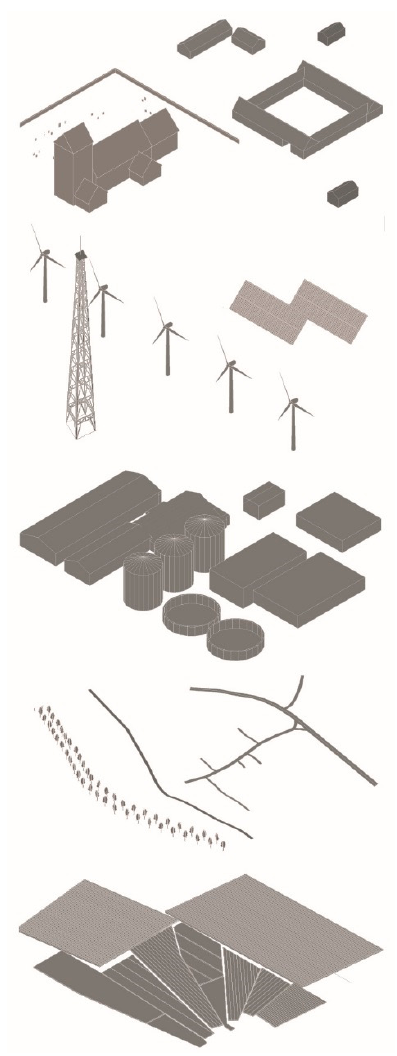
Figure 5. Analysis of the dominating elements in the cultural landscape. The figure was removed from the article in By og Land , but is presented here as it is considered essential to understanding the project.